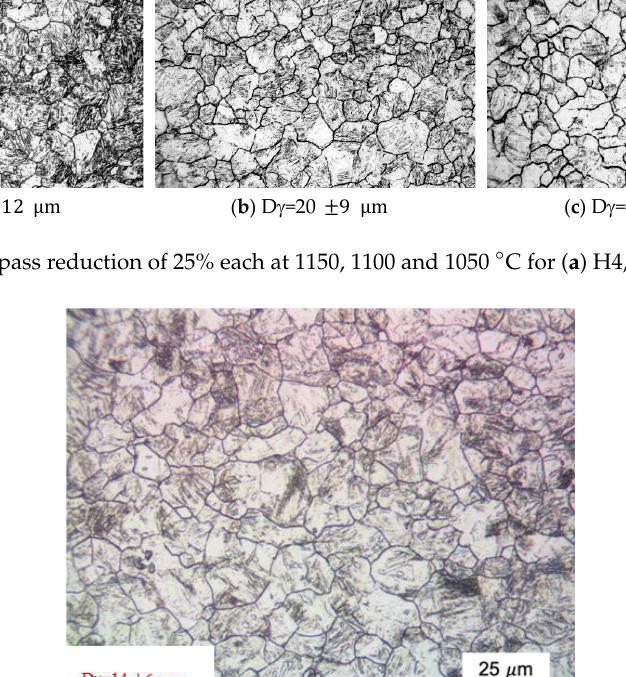
Figure 16. L8 subjected to three passes of 25% each at 1150, 1100 and 1030 °C; the interpass time was 15 s. The compression axis is vertical.